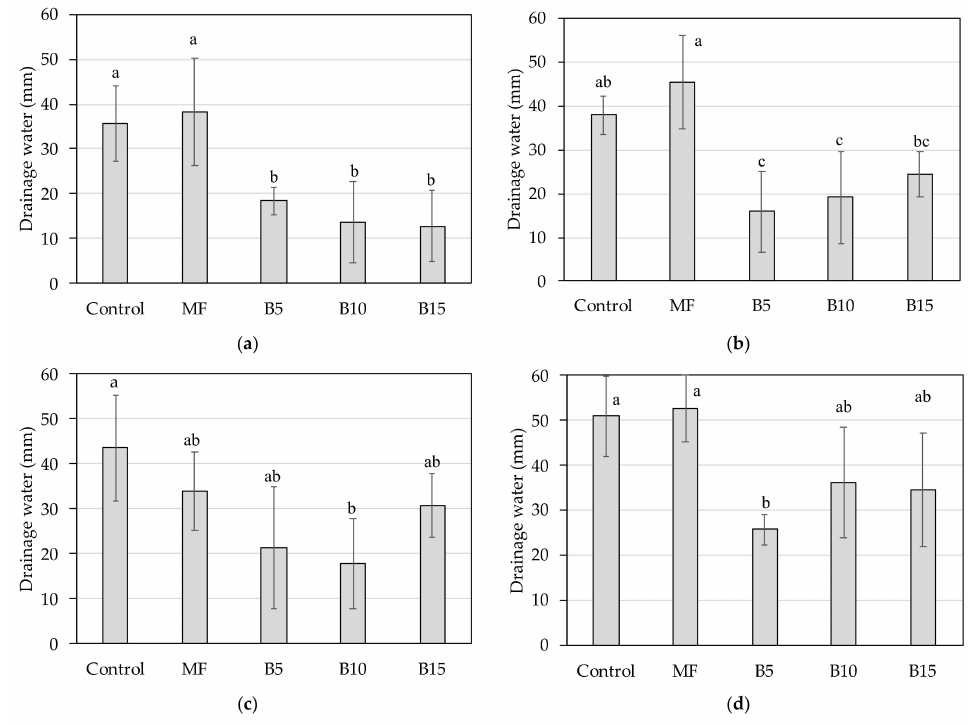
Figure 6. Total drainage volumes, as affected by fertilization treatment in ( a ) barley; ( b ) common wheat; ( c ) durum wheat; and ( d ) oat. Bars with different letters are significantly different according to Tukey’s test ( p > 0.95). Error bars represent standard deviation.